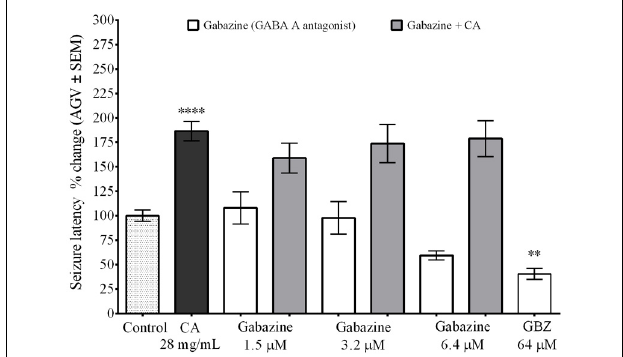
FIGURE 2 | Interaction between C. aurantium extract and GABA A receptors. Fish were allowed 1h absorption in various concentrations of selective GABA A receptor antagonist gabazine, followed by 1h absorption on C. aurantium extract at 28mg/mL prior exposure to PTZ 3mg/mL. Gabazine alone had no significant effect when compared to the control animals. Neither when administered before C. aurantium 28mg/mL extract. Results are shown as average ± SEM of at least three experiments, n > 12. ∗∗ vs. Naive P < 0 . 01; ∗∗∗∗ P < 0 . 0001.